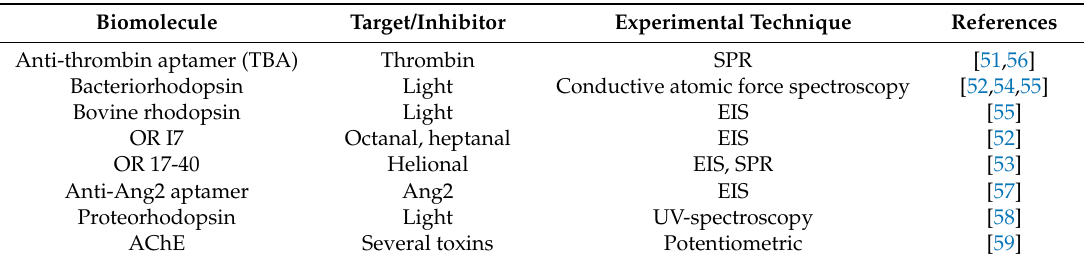
Table 2. List of the principal proteotronics case